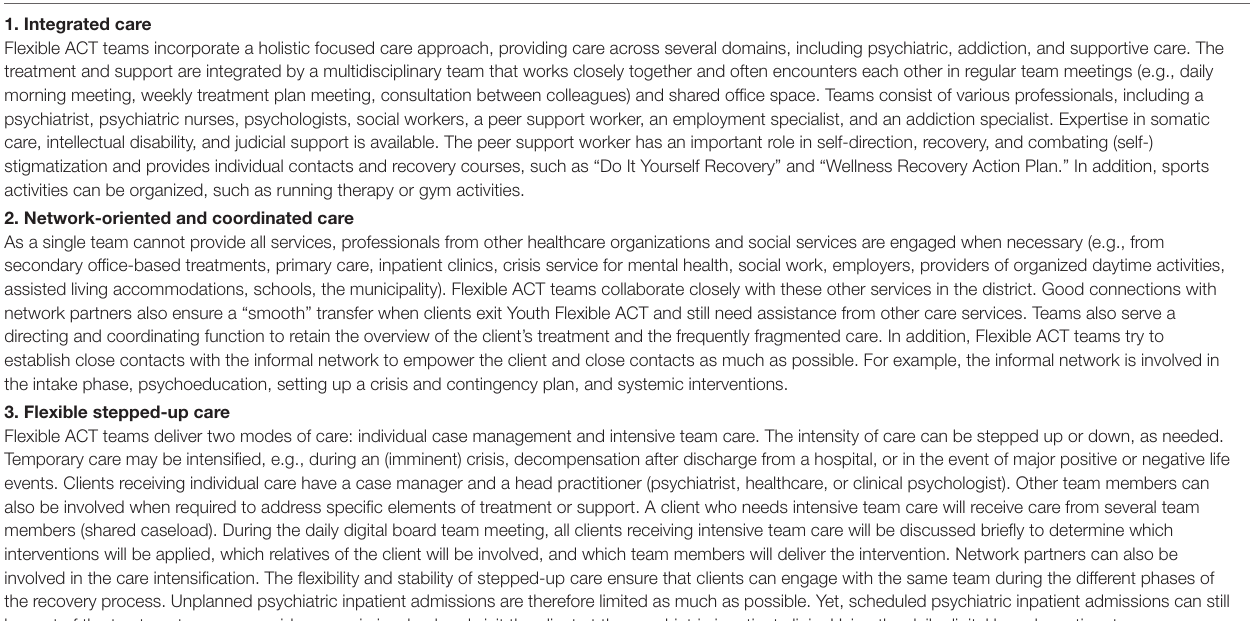
TABLE 2 | Core principles of Flexible